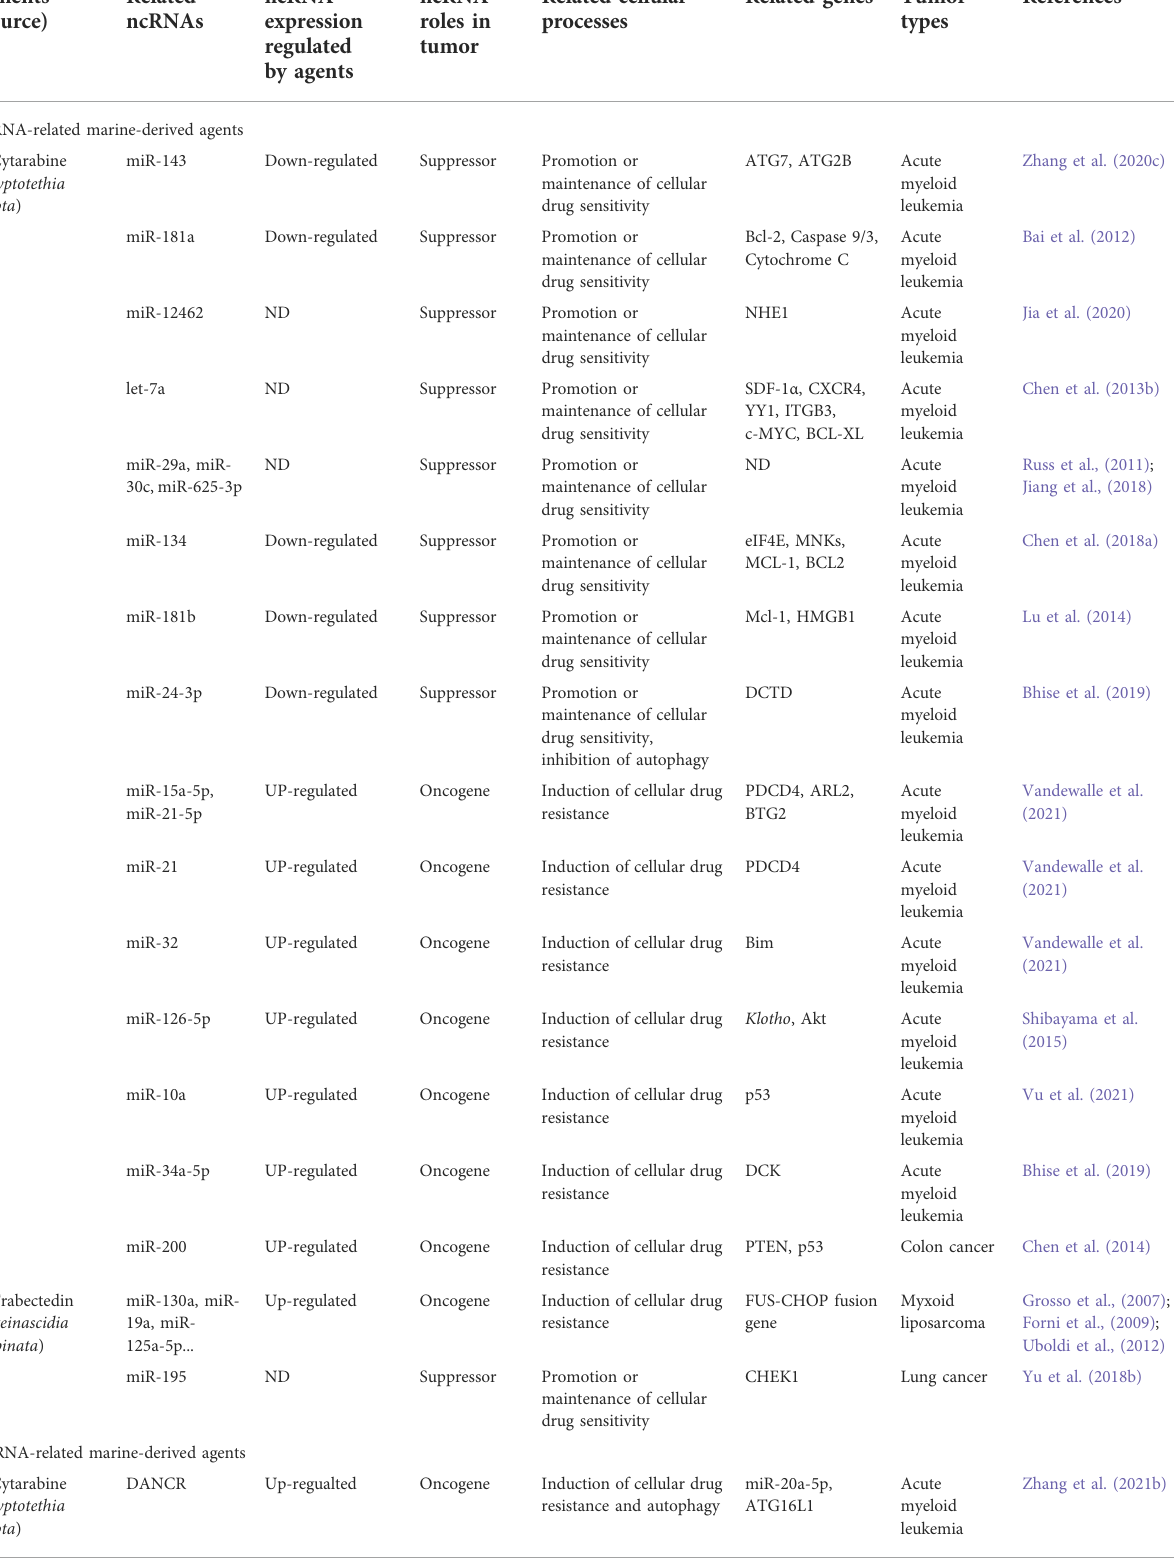
TABLE 2 Marine-derived agents associated with ncRNAs in tumor drug sensitivity and